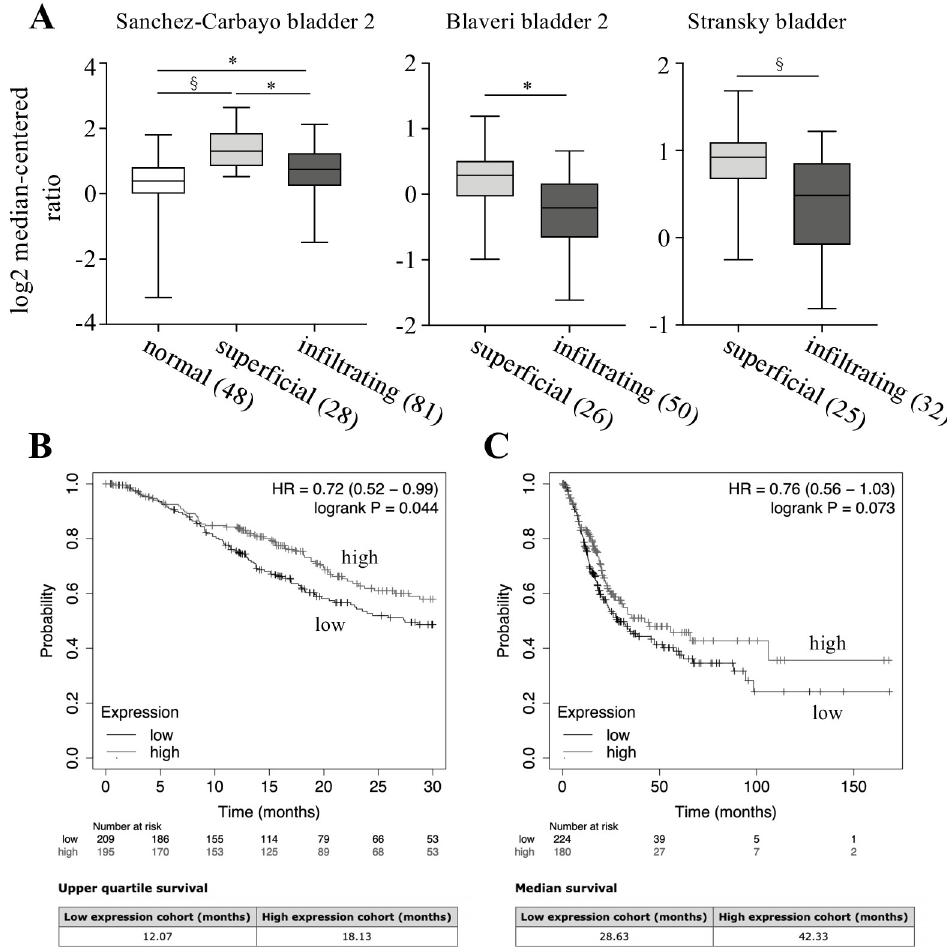
Fig 6. Spred2 expression in overall survival of patients with bladder cancer. (A) Statistical analyses of Spred2 expression in normal, superficial bladder cancer (superficial) and infiltrating bladder urothelial carcinoma (infiltrating) from 3 different datasets (Sanchez-Carbayo bladder 2, Blaveri bladder 2, and Stransky bladder) were shown. The numbers in parentheses indicates the number of samples. § p < 0.01, � p < 0.0001 (unpaired two-tailed t test). (B, C) Kaplan-Meier analysis of the data in www.kmplot.com was used to determine the survival probability for 30 months (B) and 150 months (C) of patients with high or low Spred2 expression, followed by the log-rank test. Spred2-NBR1 complex enhanced Spred2-mediated ERK inhibition upon stimulation with fibroblast growth factor (FGF), suggesting that Spred2/NBR1-dependent down-regulation of ERK-MAPK is achieved via directed endosomal trafficking of activated receptors [43]. Sprouty proteins, members of the Sprouty/Spred family, were distributed throughout the cytosol, which underwent rapid translocation to membrane ruffles following epidermal growth factor (EGF) stimulation [45]. In urothelial tumors, we showed that membranous Spred2 protein was often detected in cancer categories, especially LGPUC and HGPUC. These results suggest that Spred2 translocates from cytoplasm to cell membrane by various stimuli in the cancer microenvironment, exerting its function as a negative regulator of ERK-MAPK. ERK activation was associated with increased Ki67 expression in salivary gland mucoepi- dermoid carcinoma [39]. Since Spred2 inhibits the ERK pathway and subsequent cell prolifera- tion, we compared the relationship between membranous Spred2 protein expression and